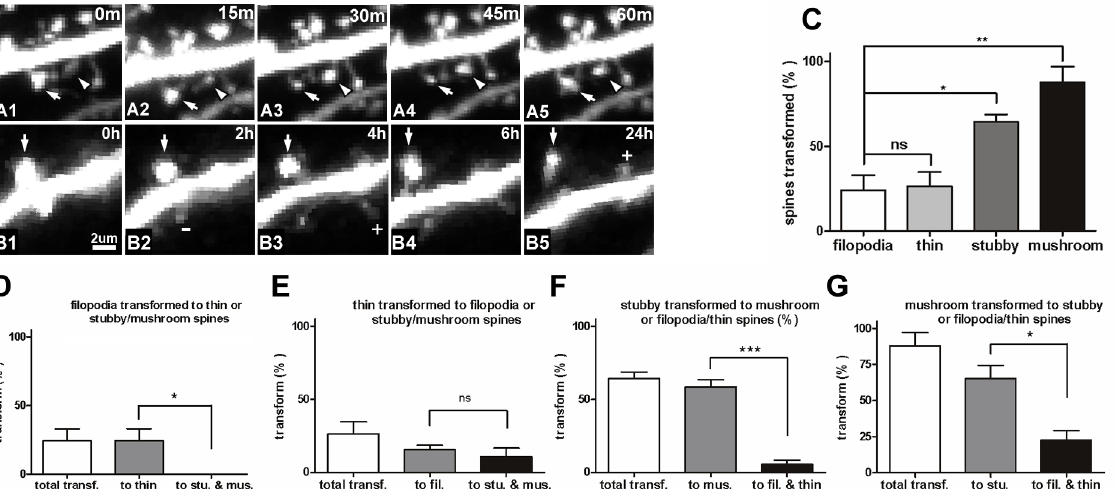
Fig 5. Transformation of dendritic protrusions into other spine types. (A) A mushroom spine (indicated by an arrow in A1) transformed into a thin spine at 30 min (A3), and reverted to a mushroom spine at 60 min (A5). Another thin spine (indicated by an arrowhead) transformed into a mushroom spine at 30 min (A3). (B) A stubby spine (indicated by an arrow in B1) transformed into a mushroom spine at 2 h (B2), remained in that shape up to 6 h (B4), and became a thin spine at 24 h (B5). “ + ” indicates newly added spines, and “ - ” indicates eliminated spines. (C) The percentage of spines that transformed into other forms during the pooled data of 15-min and 2-h interval observations. (D – G) Percentage of each spine type that transformed into other types. (D) All filopodia transformed into thin spines, and a few transformed into large spines ( P < 0.05). (E) Some changed thin spines transformed into filopodia, and some transformed into large spines; no significant difference was observed between these two forms. (F) Most of the stubby spines transformed into mushroom spines, and only a few transformed into small spines ( P < 0.001). (G) Most of the mushroom spines transformed into stubby spines, and only a few transformed into small spines ( P < 0.05). Figure labels: trans. = transformation, fil. = filopodia, stu. = stubby, and mus. = mushroom. Neurons used for transformation analysis were from the 15-min short-term and 2-h middle-term observations. Bars indicate means ± SEM. Significance was set at * P < 0.05, ** P < 0.01, and *** P < 0.001.